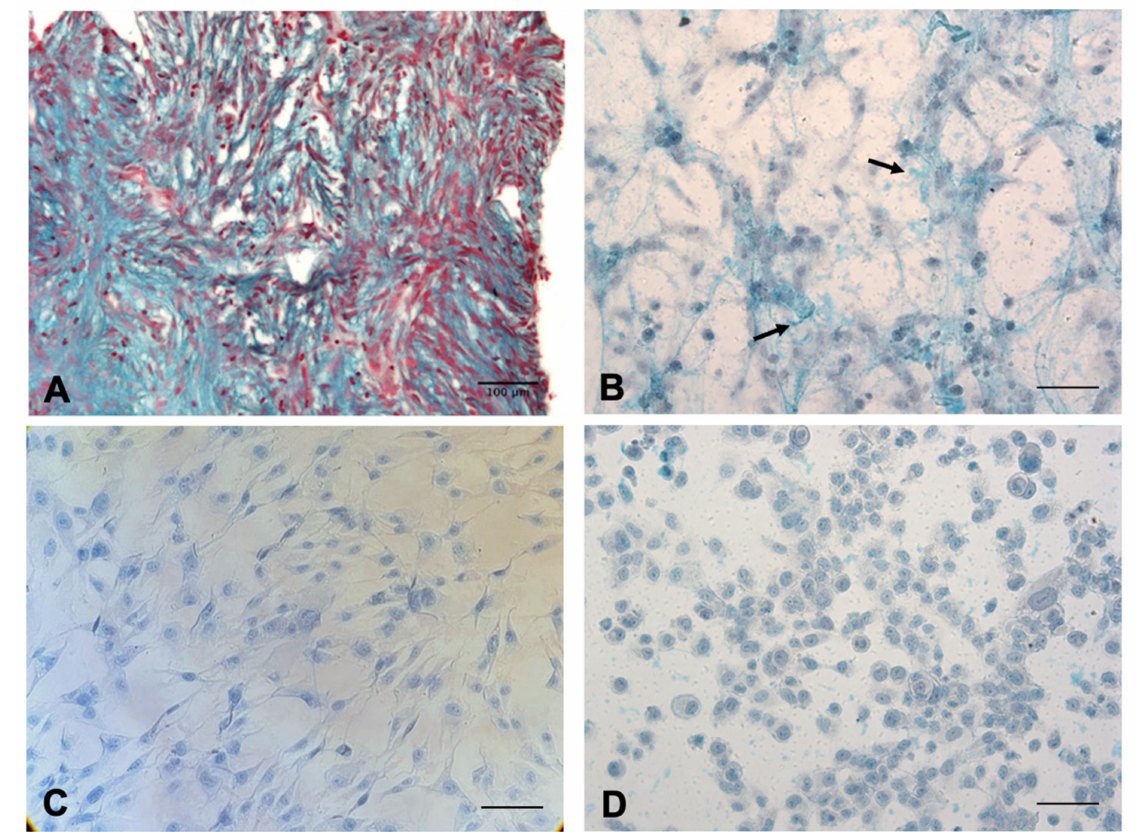
Figure 1. ( A ) Hyaluronic acid (HA) presence in the malignant pleural mesothelioma (MPM) tumor microenvironment. Histochemical staining with Alcian Blue highlighted HA distribution in MPM tissue sections; in particular, the staining was visible in tumor-associated stroma. Nuclei were stained with Fast Red. Magnification, 200 × , scale bar, 100 µ m. ( B – D ) MPM primary cells are able to produce HA by themselves, as compared to normal mesothelial cells Met5A. Alcian blue staining in MPM primary cells highlighted the presence of HA around the cells (indicated by black arrows) ( B ). Hyaluronidase treatment allowed the removal of HA staining ( C ). As a further control, Met5A cells, a normal mesothelial cell line, do not show the capability to produce HA ( D ). Original magnification, 200 × , scale bar, 50 µ